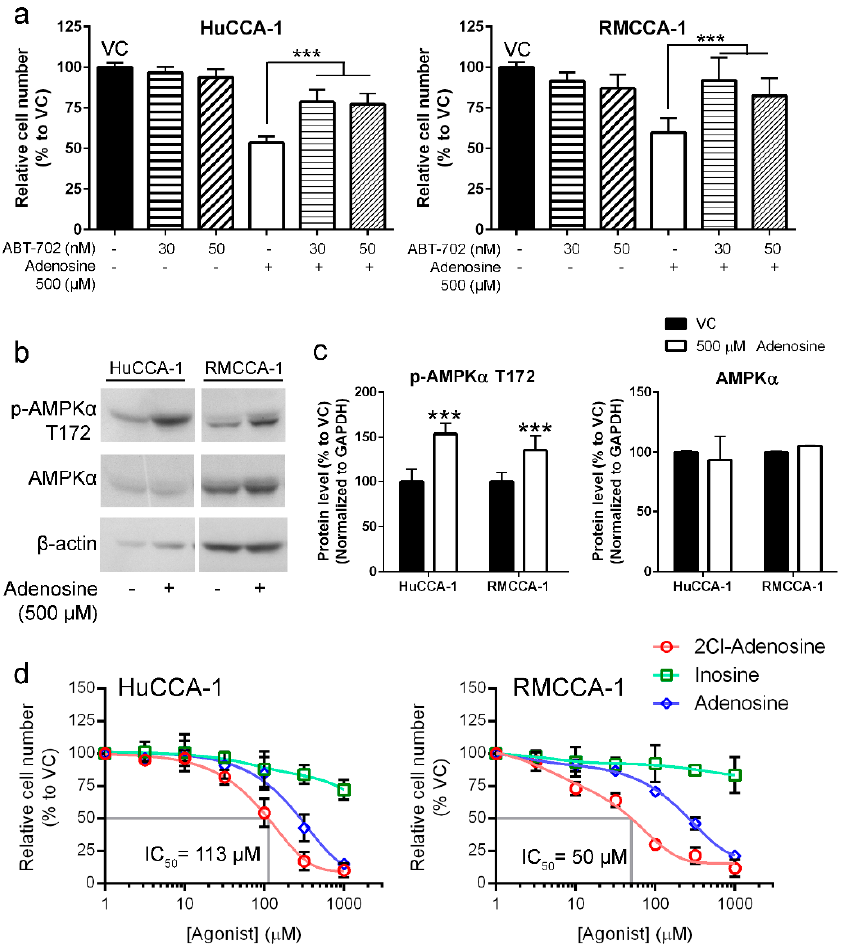
Figure 6. Adenosine inhibited CCA cells through a conversion to AMP. ( a ) MTT assay showed CCA cell viability after 24 h adenosine treatment with or without ABT-702, an inhibitor of AMP-producing enzyme: adenosine kinase. ABT-702 was able to reduce adenosine’s inhibitory effect. ( b ) Adenosine treatment increased phosphorylated form of AMPK α after 24 h of the treatment. ( c ) Semiquantitative data of protein levels in ( b ). ( d ) 2-Chloroadenosine (2Cl-adenosine) also inhibited CCA cell lines in MTT viability assay but inosine had only little effect on CCA cell viability. VC; vehicle control, *** p < 0.001. All experiments were performed at least three biological replicates with internal triplicate. Graphs were plotted as mean ±